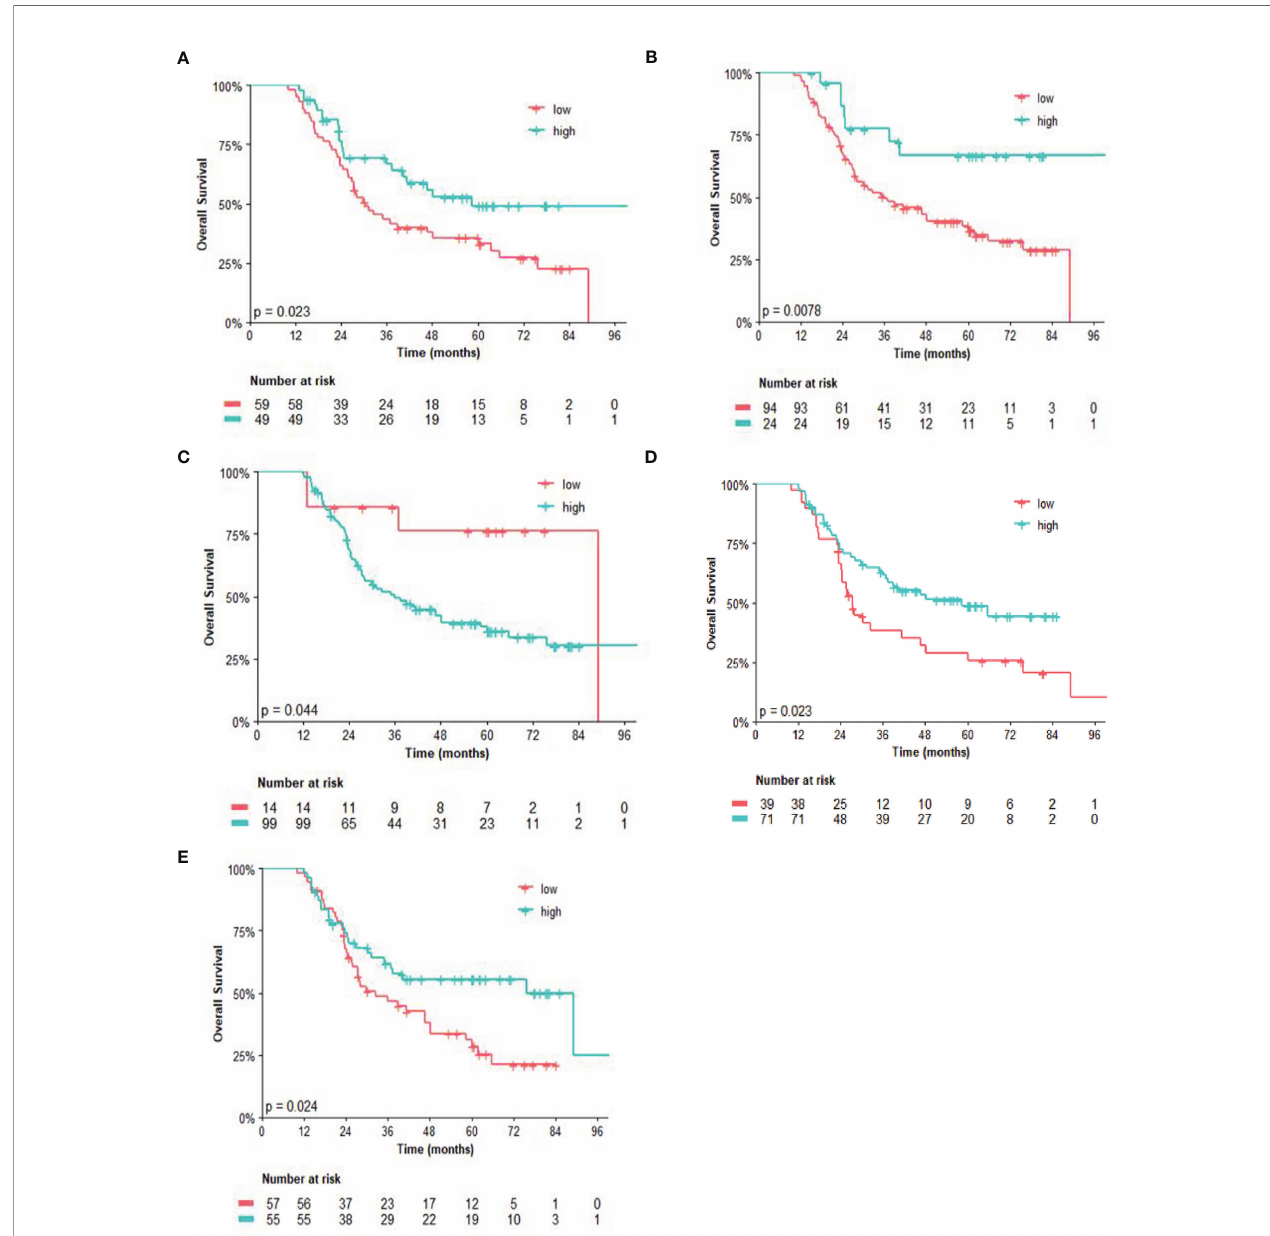
FIGURE 3 | Overall survival (OS) by (A) CD3; (B) CD8; (C) CD14; (D) CD4/FOXP3 ratio; and (E) CD8/FOXP3 ratio. Regarding the immunohistochemistry markers and the ratios, Kaplan – Meier curves for EFS were strati fi ed according to the cutoff for prognostic evaluation and divided into low versus high subgroup for each variable subsets. The red solid line indicates patients with low values and the blue solid line indicates patients with high values. Tick marks indicate censored